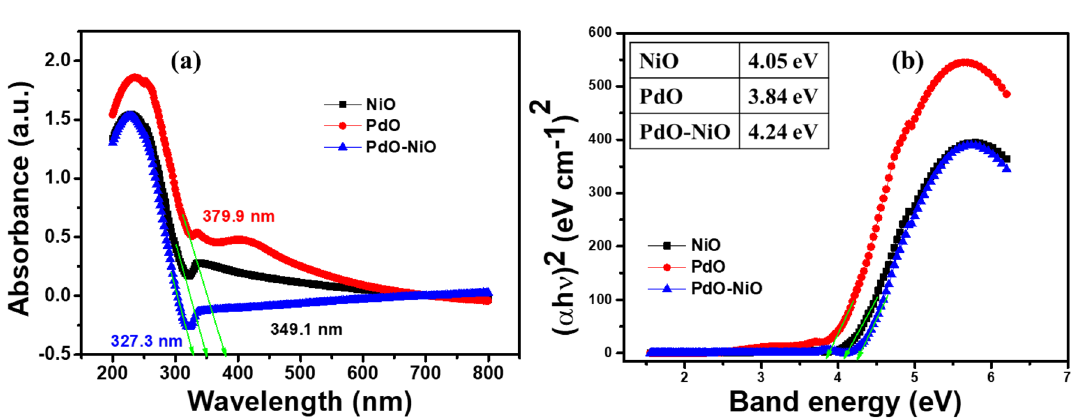
Figure 5. ( a ) UV–Vis absorption spectra and ( b ) Plot of (αhν) 2 Vs hν for NiO, PdO and PdO–NiO nanocomposite (Inset shows the bandgap energy of the